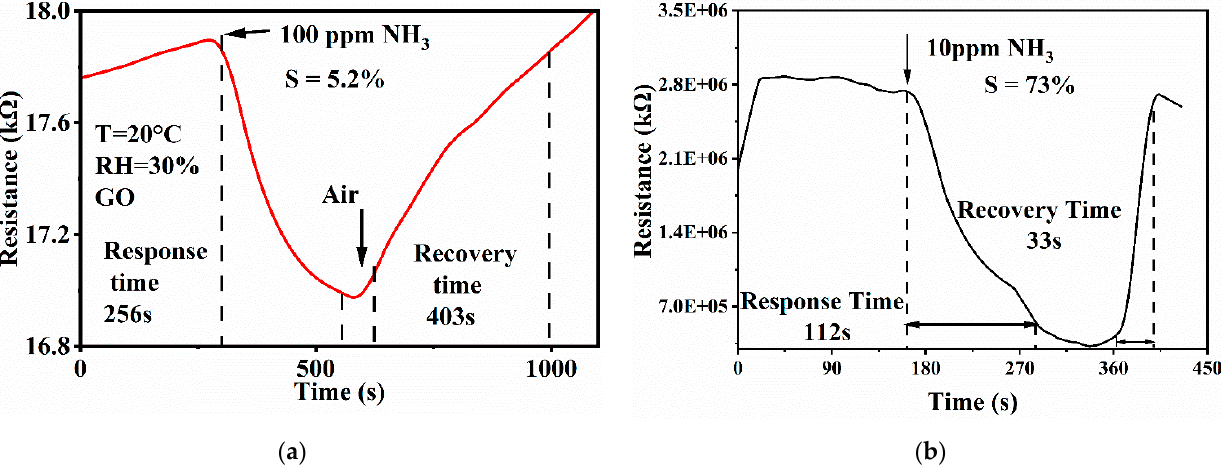
Figure 5. Response curves comparison of ( a ) GO and ( b ) S-1.